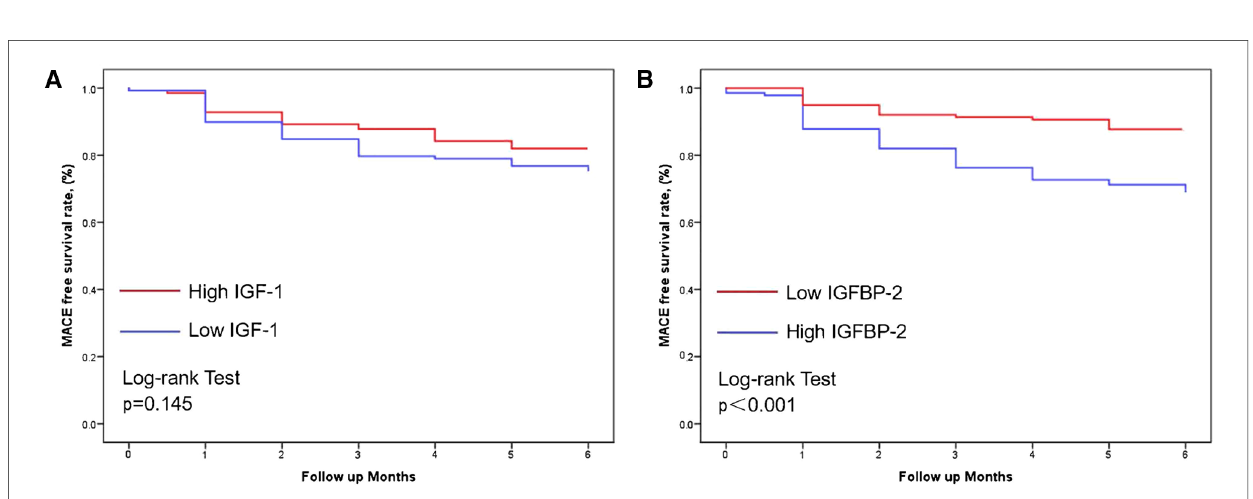
FIGURE 2 Kaplan-Meier curves in patients with ACS with individual levels of IGF-1 ( A ) and IGFBP-2 ( B ) during follow-up ( p =0.145 and <0.001, respectively). MACEs, Major adverse cardiovascular events; ACS, Acute coronary syndrome; IGF-1, Insulin like growth factor 1; IGFBP-2, Insulin like growth factor binding protein